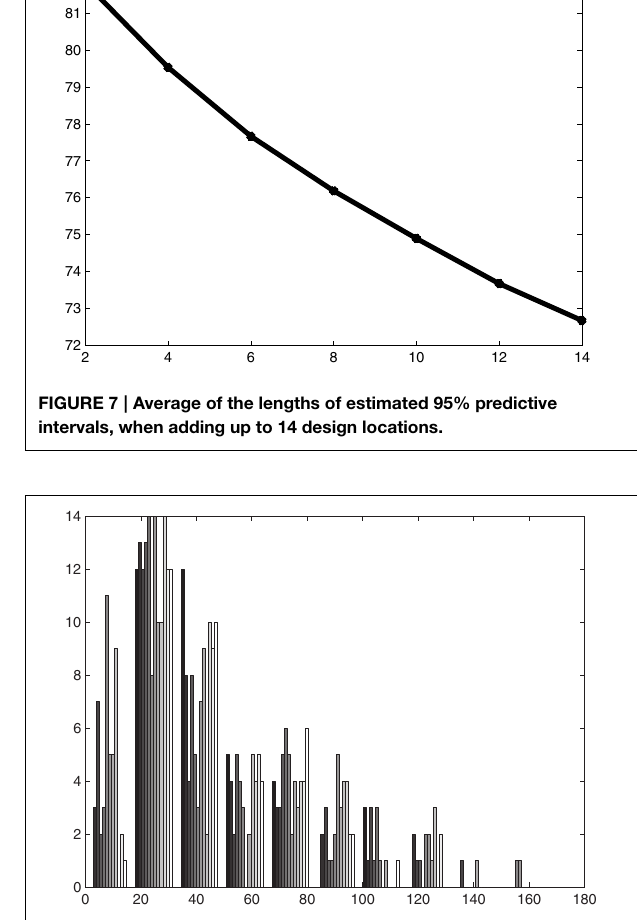
FIGURE 8 | The 12 histograms of the rainfall residuals + 53 in different shades of